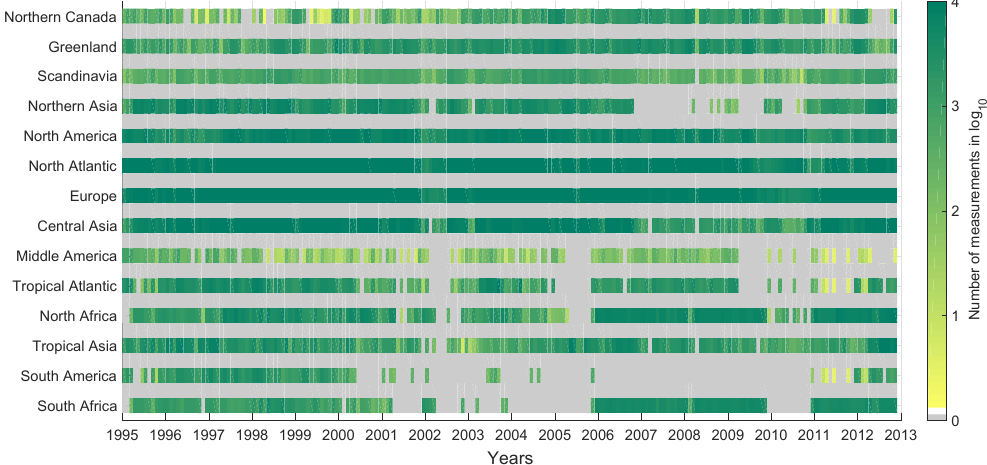
Figure 4. Data density at cruise altitude ( p < 350hPa) for all defined regions on a logarithmic scale (color) for the period analyzed.